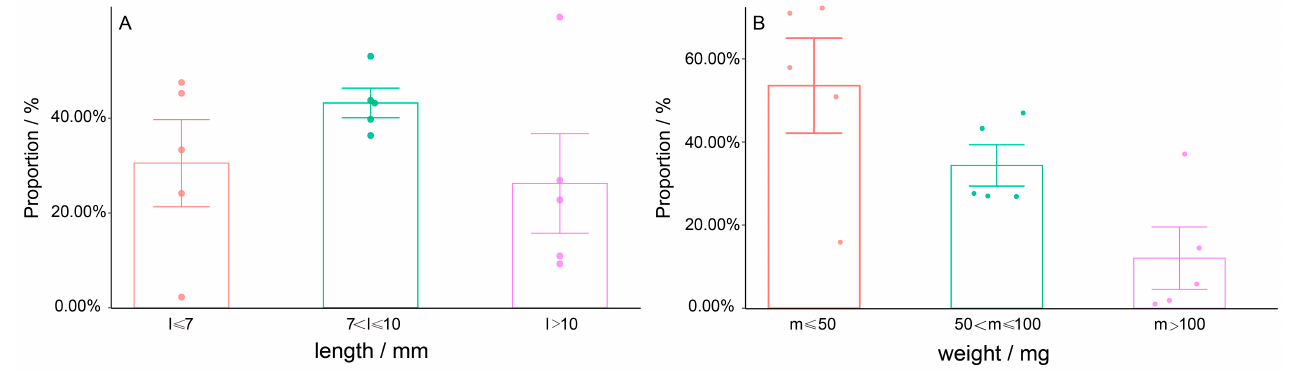
Figure 4. The averaged proportion of length ( A ) and weight ( B ) (mean ± S.D.) in total based on each habitat.